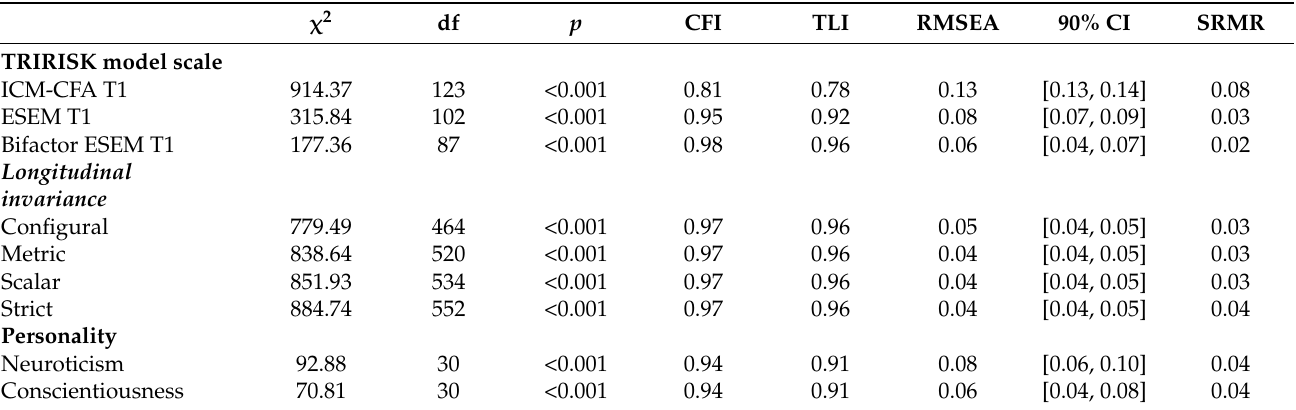
Table 1. Model fit indices of the measurement